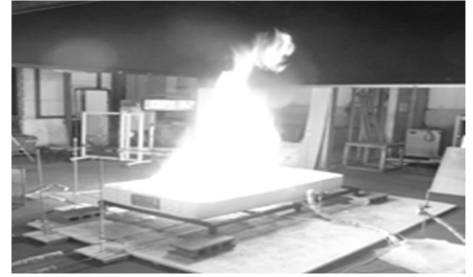
Figure 3. Mattress combustion location.